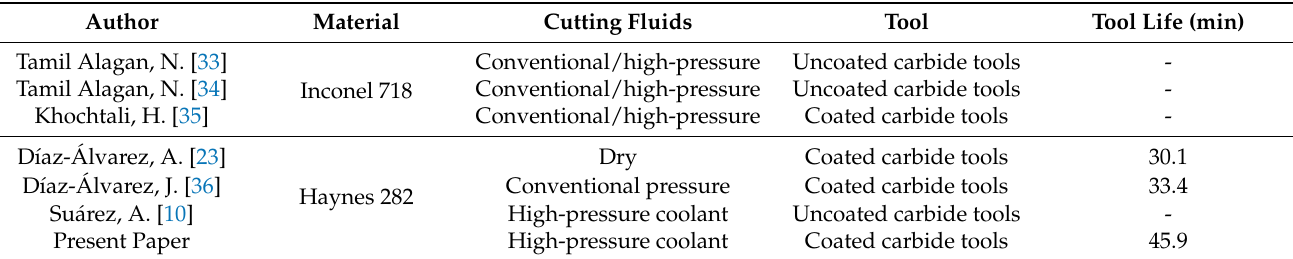
Table 1. Authors’ contribution in Haynes 282 and Inconel 718